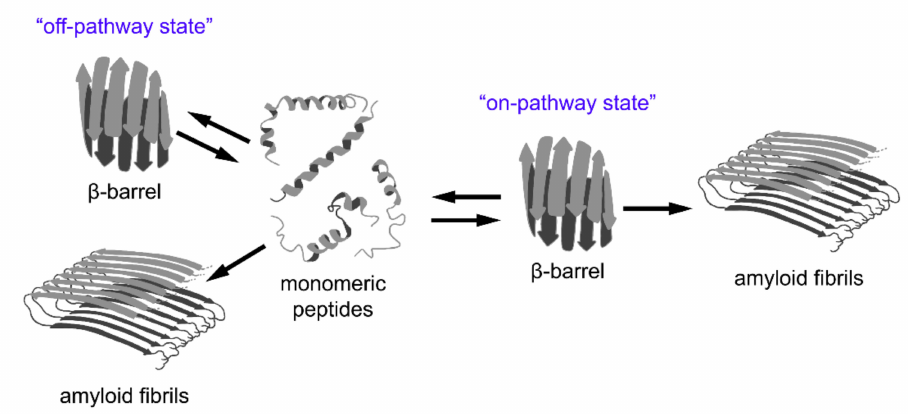
Figure 3. A relationship between β -barrel formation and amyloid fibril formation. According to recent observations, short peptides with different structures may form stable oligomers with β -barrel topology (so-called “cylindrins”). This state can be intermediate on the pathway of fibrillogenesis (“on-pathway state”), or can form as a result of an alternative assembly of partially unfolded monomers (“off-pathway state”). The β -barrel oligomers are considered to be highly toxic species involved in the pathogenesis of various diseases and, therefore, could represent promising targets for their